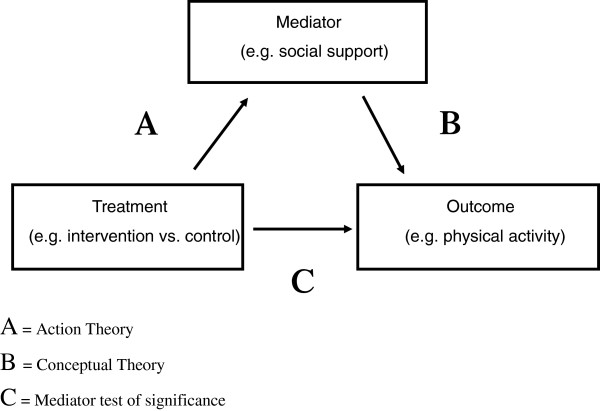
Mediation analysis overview.